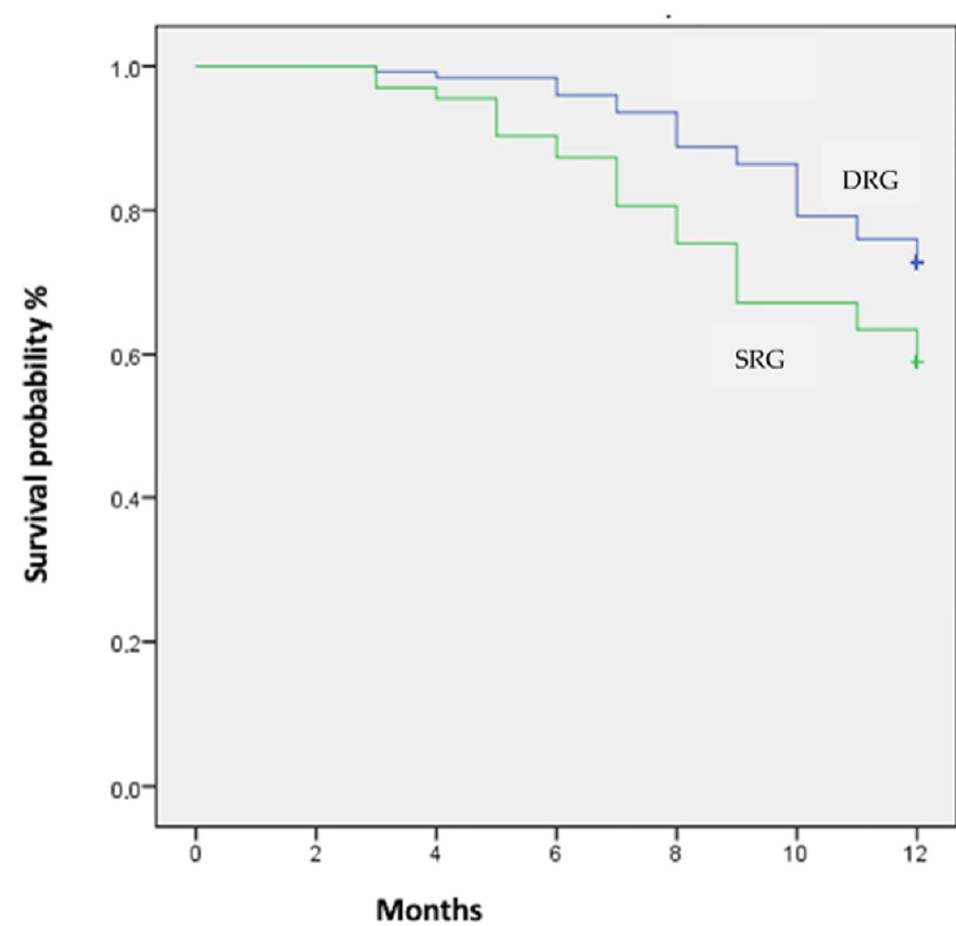
Figure 3. Kaplan–Meier curves for primary outcome at the 1-year follow-up stratified for DRG and SRG. Table 4. Results of multivariate analysis for the improvement in NYHA class and EF. DRG: